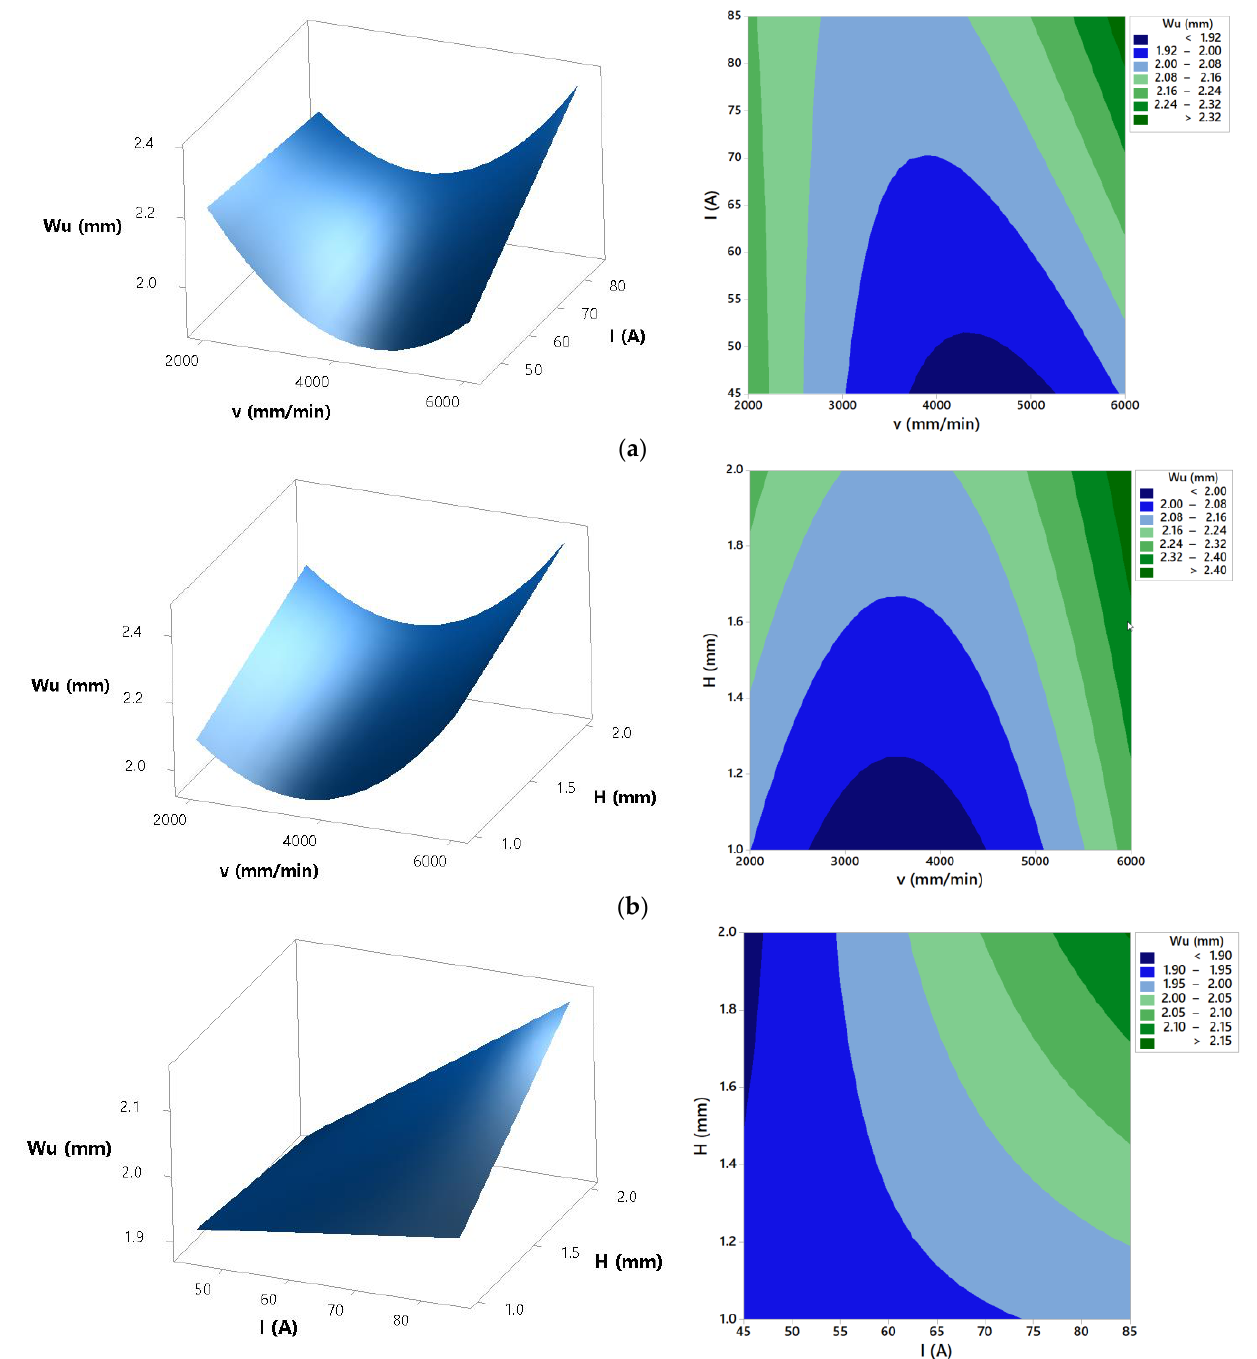
Figure 6. Effects of process parameters on top kerf width: ( a ) H = 1.5 mm, ( b ) I = 85 A, and ( c ) v = 4000 mm/min.